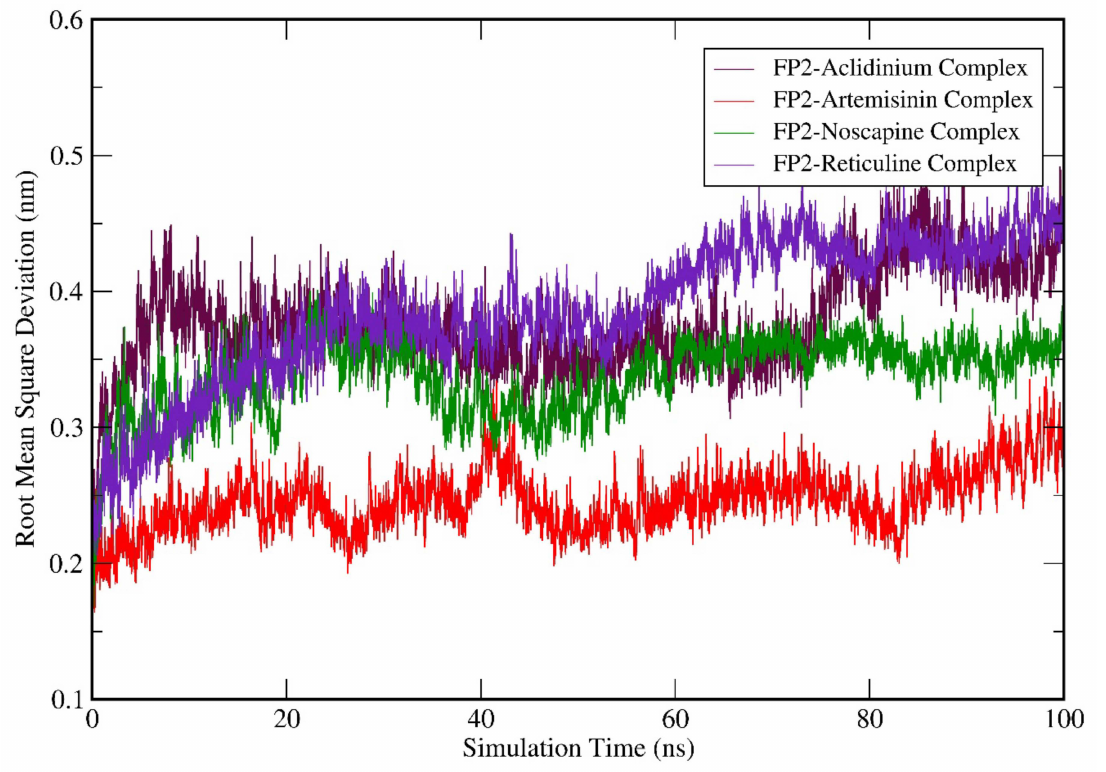
Figure 4. Molecular dynamics simulation (MDS) result analysis for FP-2-Artemisinin, FP-2 Noscapine, FP-2 Reticuline, and FP-2 Aclidinium complexes representing RMSD (Root mean square